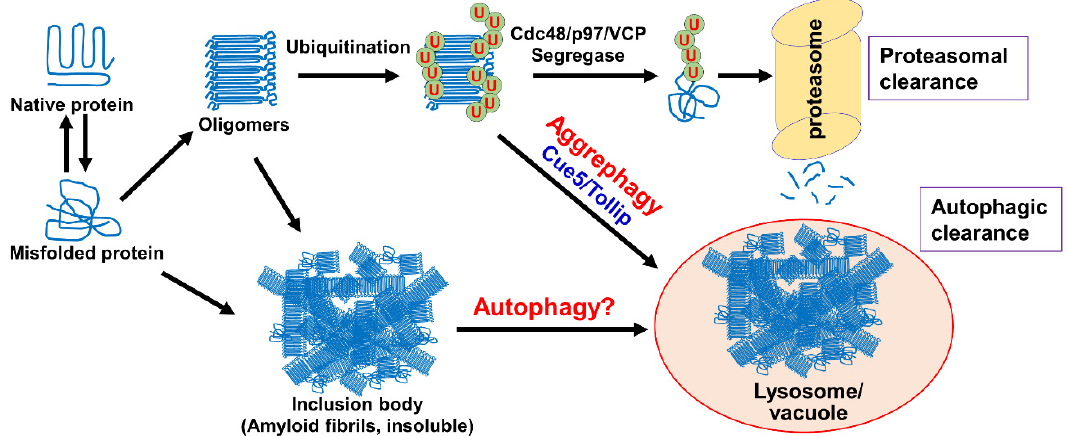
Figure 1. The clearance of misfolded proteins by the ubiquitin proteasome system and autophagy.